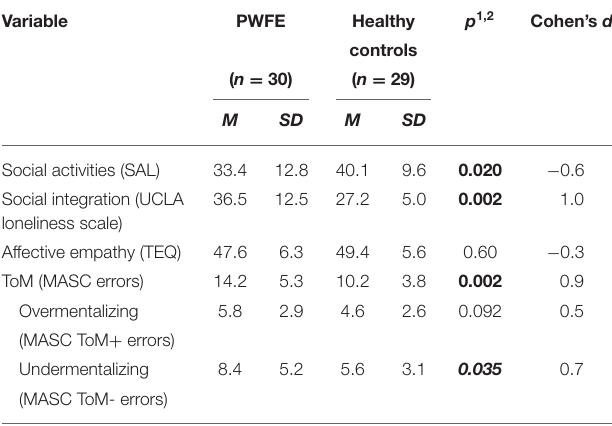
TABLE 3 | Measures of social functioning and social